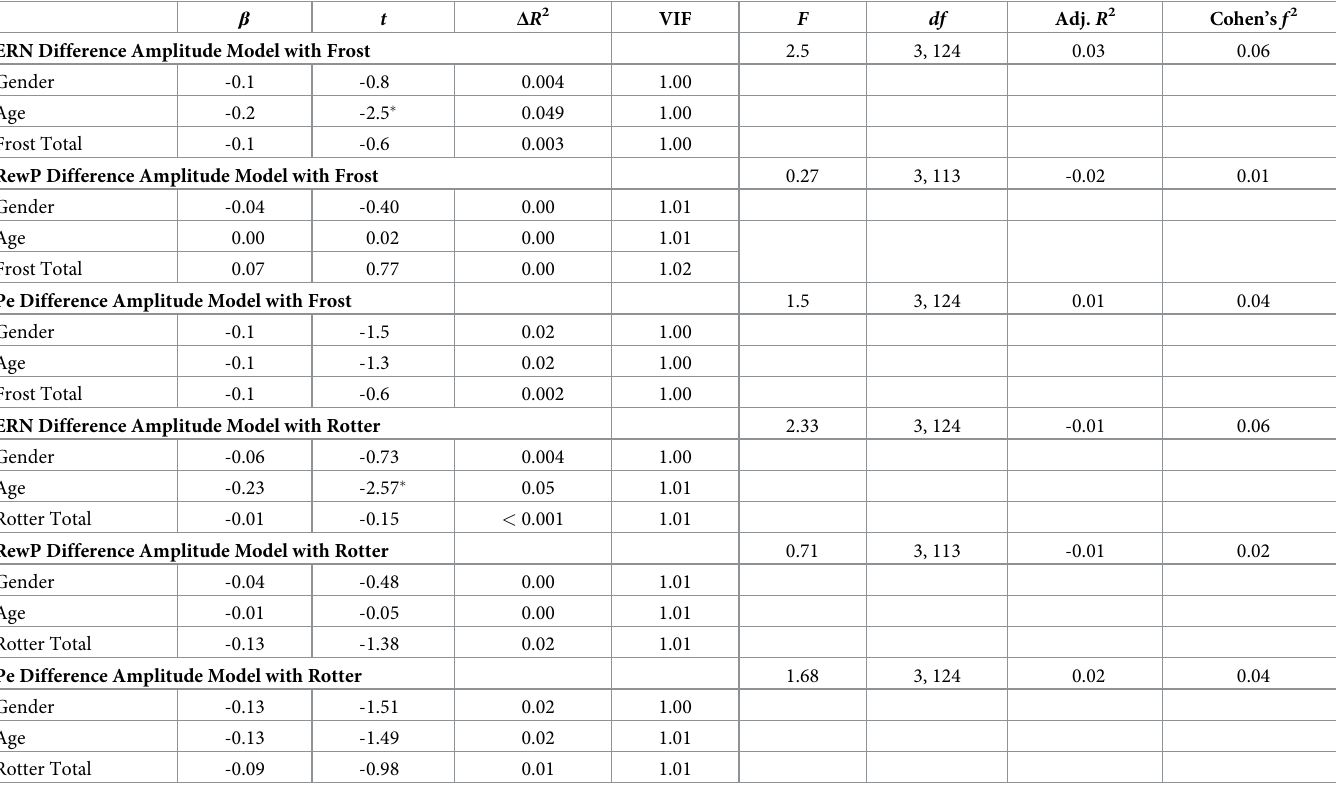
Table 3. Multiple linear regressions with Frost Perfectionism scale and Rotter locus of control predicting difference